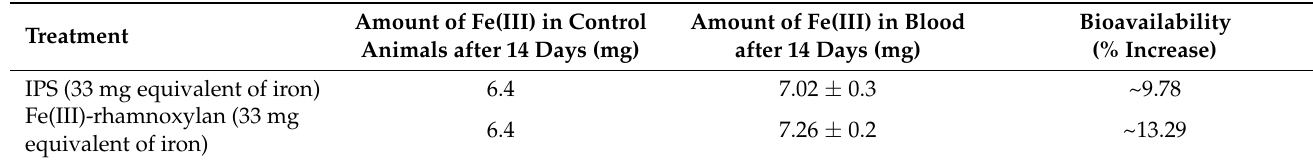
Table 3. Bioavailability data of Fe(III)-rhamnoxylan and